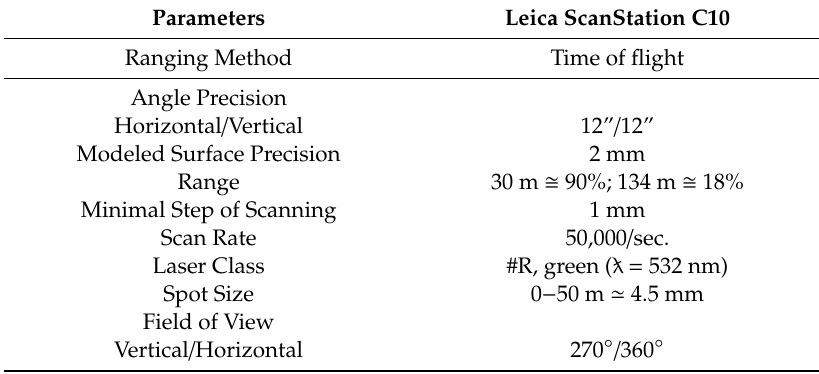
Table 3. Leica ScanStation C10 technical